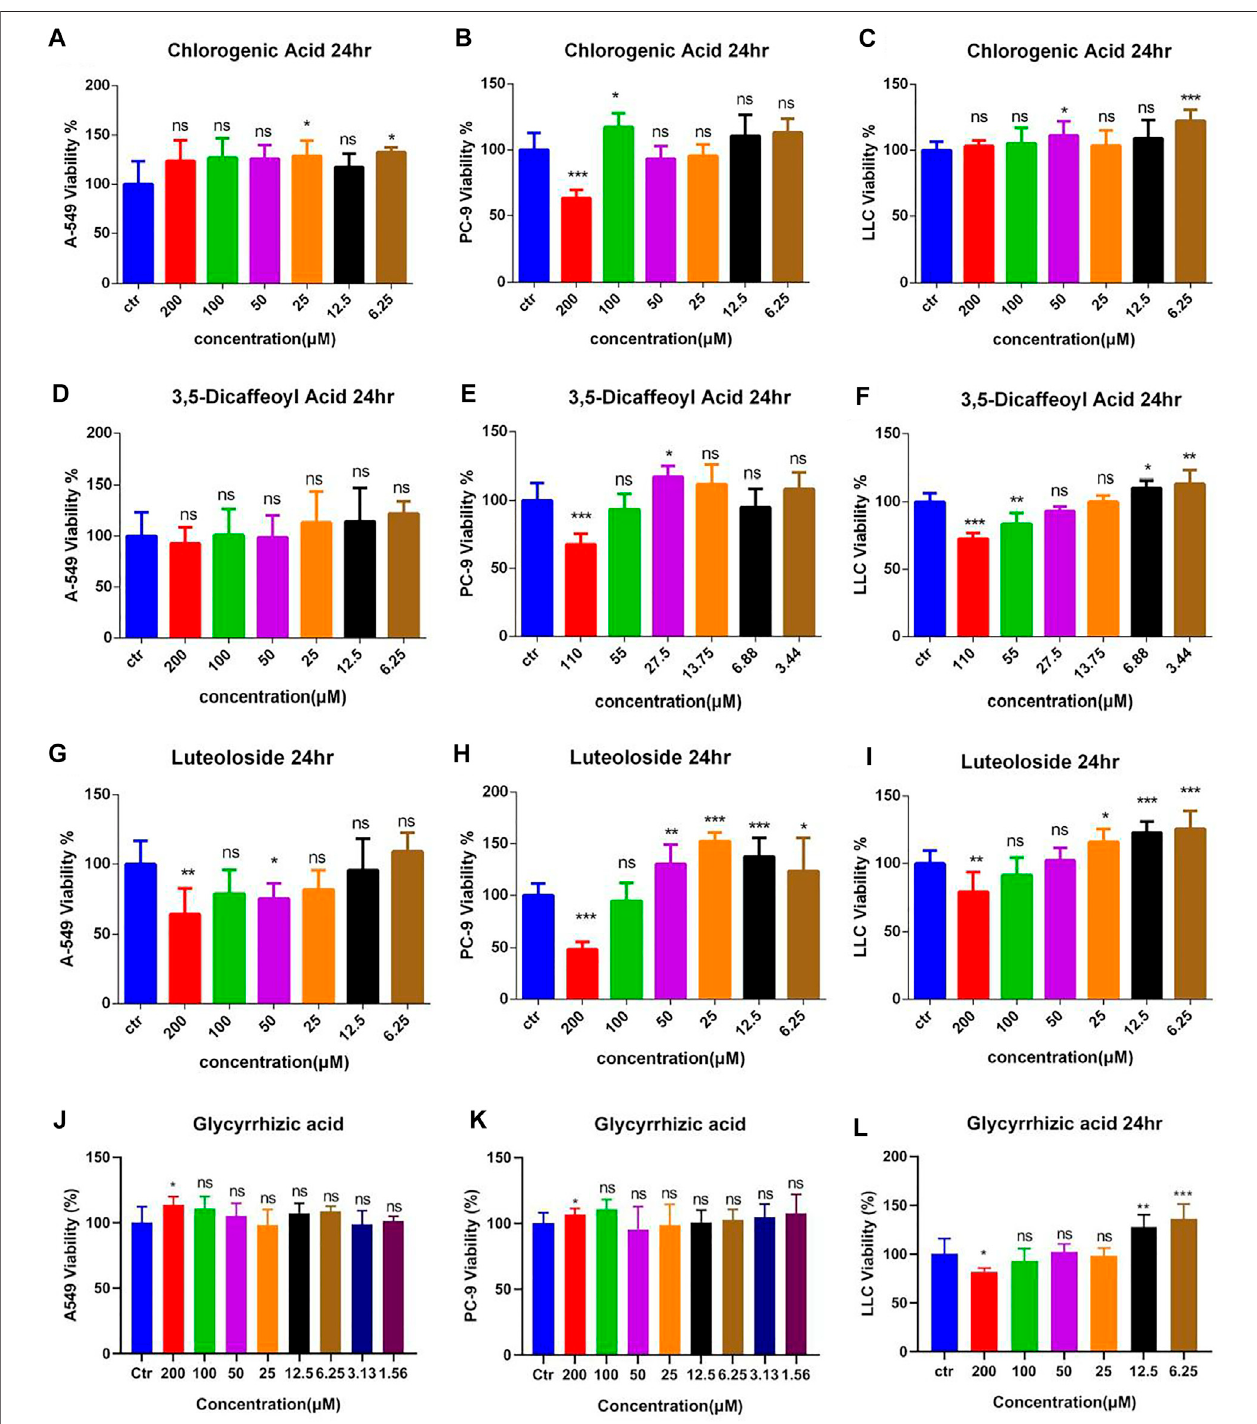
FIGURE7| Theeffectsofdifferentcompoundontheviabilityoflungcancercells. (A – C) DosageofchlorogenicacidontheantitumoractivityofDDPinA549,PC-9, andLLCcells. (D – F) Doseof3,5-dicaffeoylquinicacidontheantitumoractivityofDDPinA549,PC-9,andLLCcells. (G – I) Dosageofluteolosideontheantitumoractivity of DDP in A549, PC-9, and LLC cells. (J – L) Dosage of glycyrrhizic acid on the antitumor activity of DDP in A549, PC-9, and LLC cells. Error bars are represented as mean ± SEM. The p values were determined by Student ’ s t test (* p < 0.05, ** p < 0.01, *** p < 0.001 versus control).